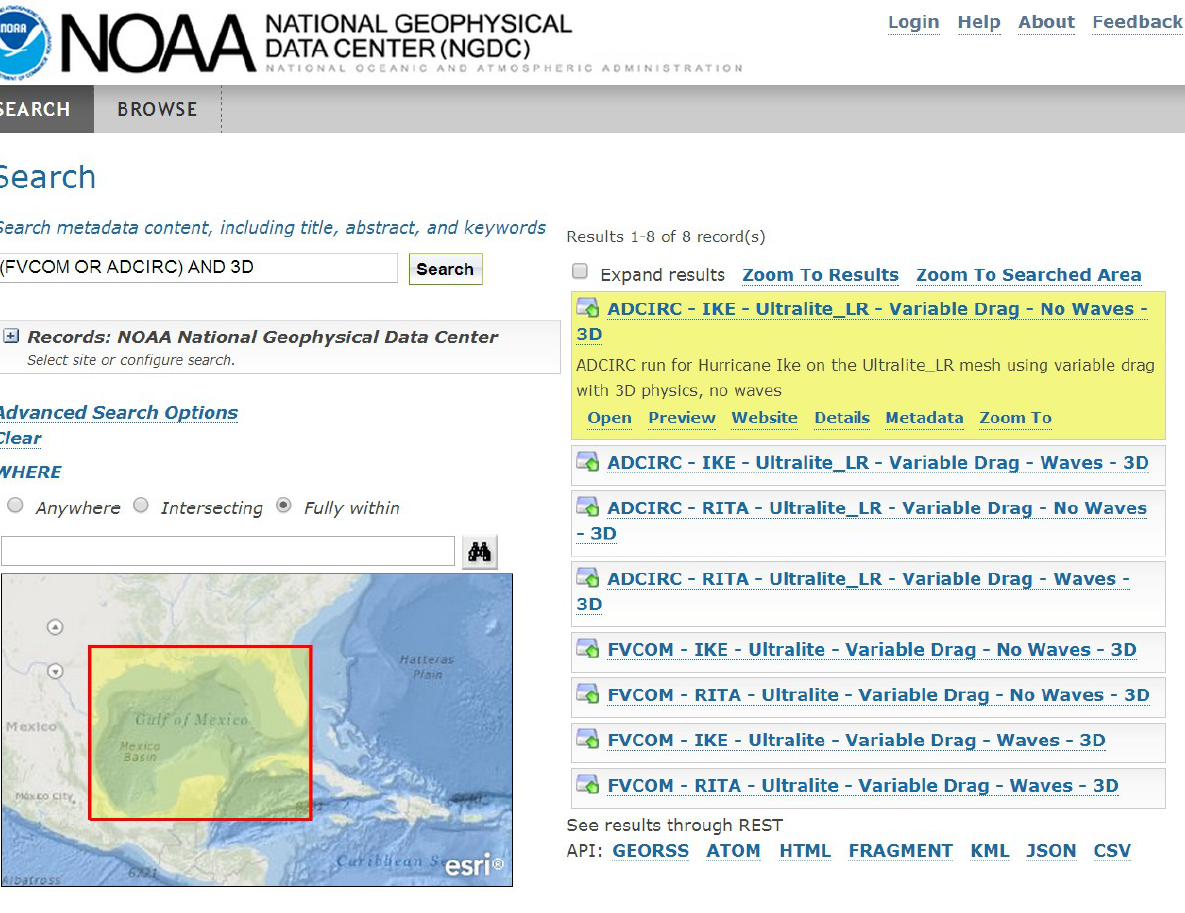
Figure 6. Results from a query for 3D FVCOM or ADCIRC datasets found within a specified bounding box (the extent of the map window). The user has selected one of the datasets returns, which displays the boundary of the dataset on the map (yellow rectangle), a summary (yellow-highlighted text), and dataset links, including ―Open‖ to access the dataset using OPeNDAP, and ―Metadata‖ to provide the full metadata